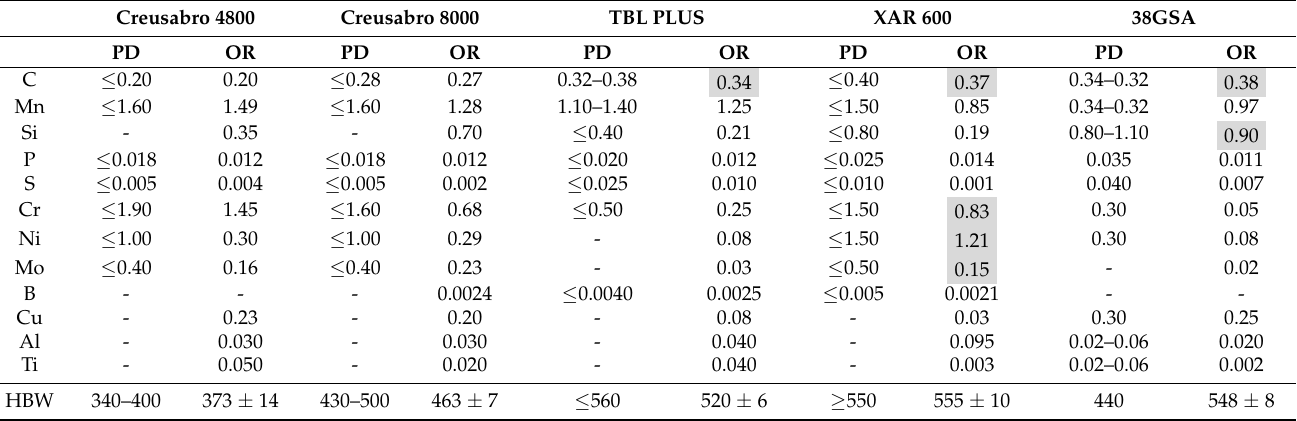
Table 1. The chemical compositions (%wt.) and hardness measurements with average standard deviation of the tested types of steels. PD—producer’s data, OR—own results [22–24]. In grey, there are marked elements which are further